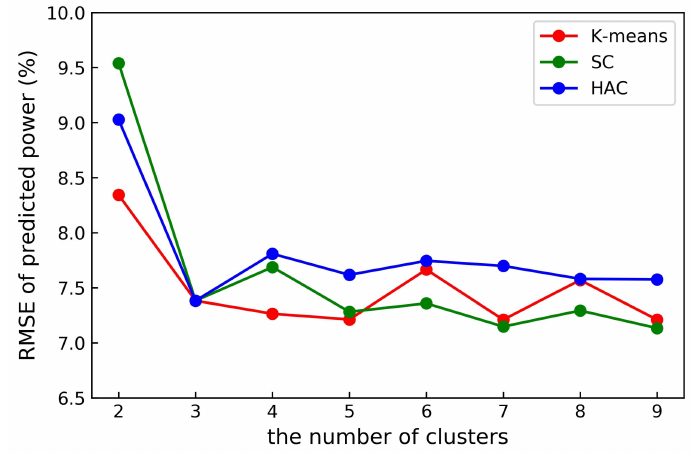
Figure 8. The annual RMSEs of different clustering WPF models as a function of cluster